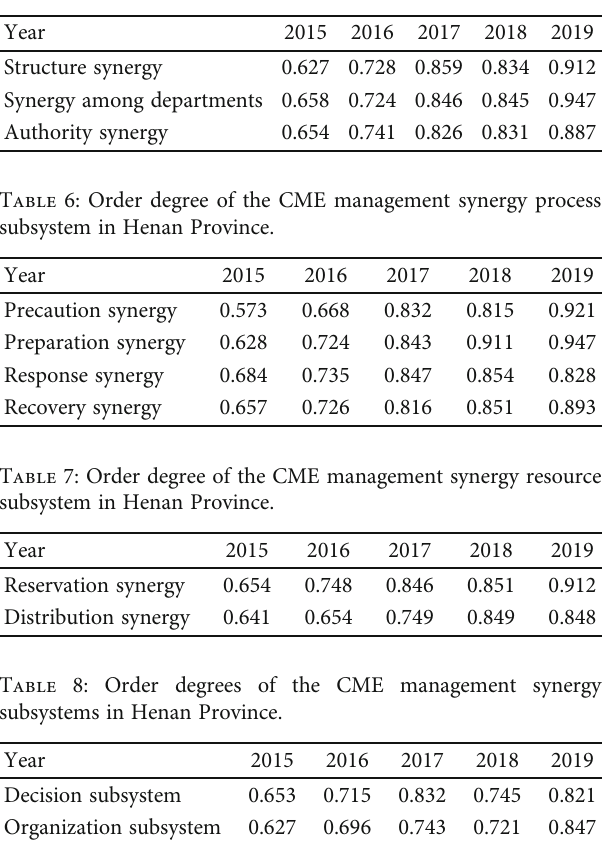
Table 5: Order degree of the CME management synergy organization subsystem in Henan Province.